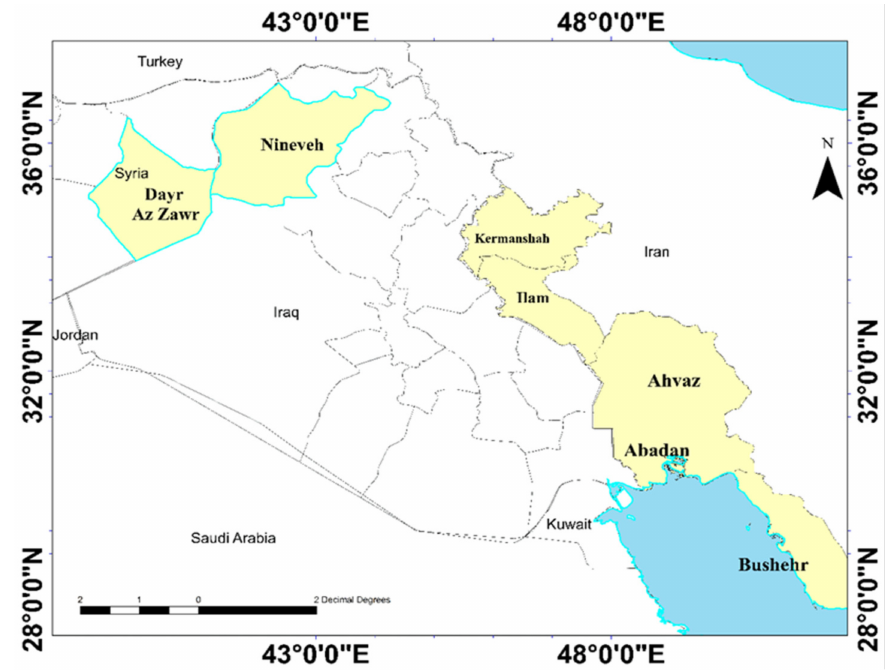
Figure 1. Study area with the 5 synoptic weather stations in SW Iran, Nineveh and Dayr Az Zawr provinces in Iraq and Syria,